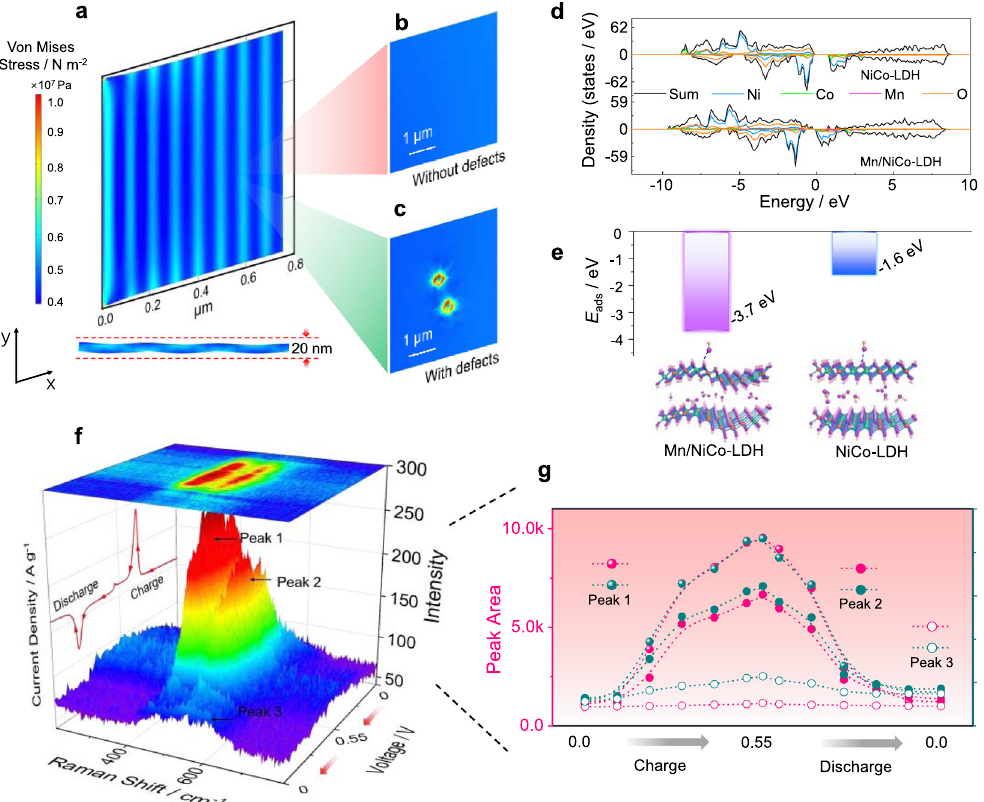
Fig. 5 Theoretical calculation and operando exploration for understanding the microstructure and reaction mechanisms. a The distribution of strain on the nanosheets with the accumulated strain generated by the compressive strain with Mn doping and the constrained force from the substrate. The displacement in the c -axis (cross-section) of nanosheets is also given at the bottom. b , c The effect of the point defects on the distribution of local strain; d DOS calculation results of Mn/NiCo-LDH and NiCo-LDH. e Adsorption energy toward OH − ions for Mn/NiCo-LDH and NiCo-LDH. f Operando Raman spectra of Mn/NiCo-LDH during the charging/discharging process (1 mV s − 1 ). g The change for the typical peak area and intensity in (f), which demonstrates the underlying charge-storage